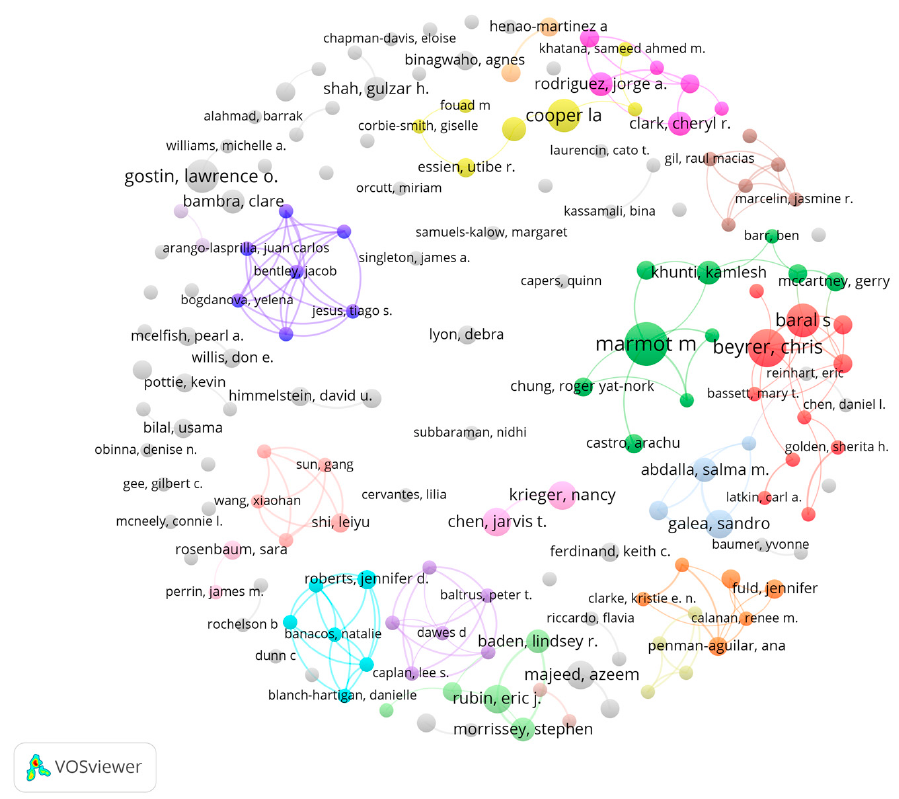
Figure 5. Co-authorship network. Note(s): Colors represent clusters, linked lines represent co-operative relationships, and node sizes represent publication numbers.